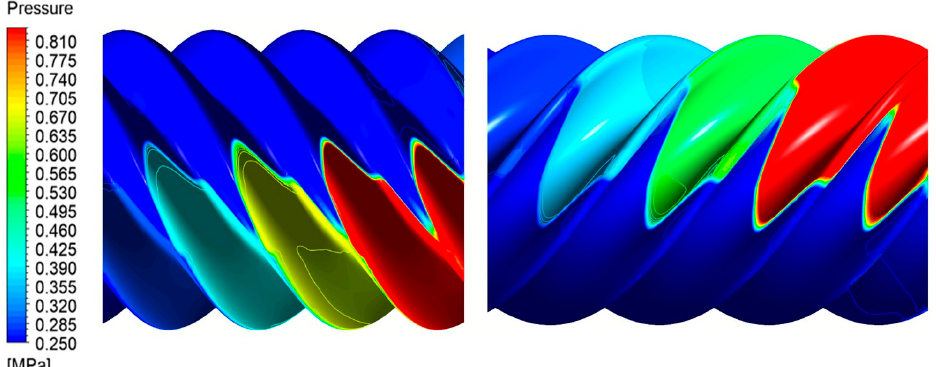
Figure 7. Sealing line on rotor surfaces of male rotor and female rotor.